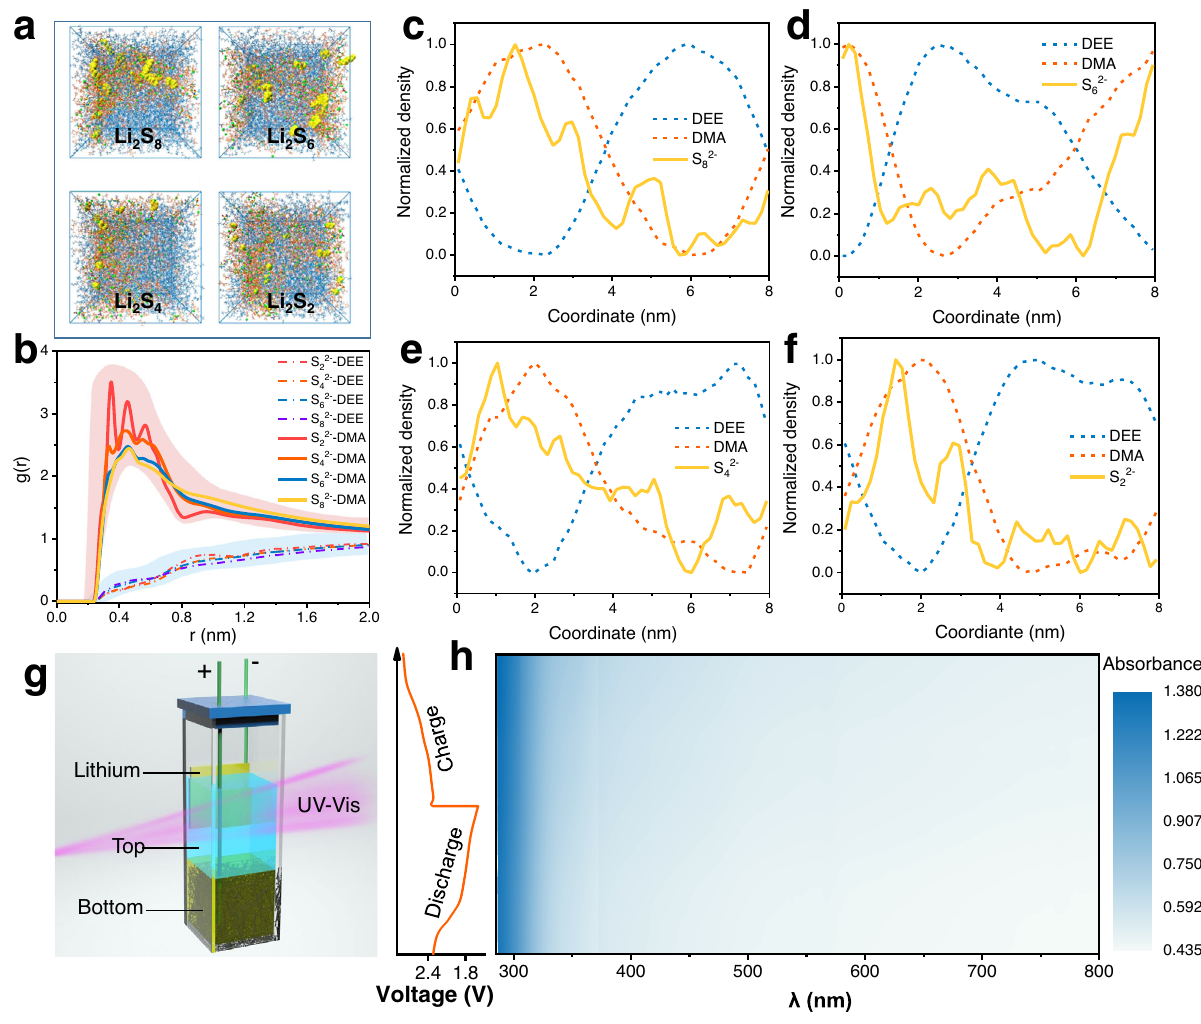
Fig. 4 | Polysul fi de-con fi nement effect of the DMA-DEE biphasic system. a Snapshots of the MD simulation of the No. 2 biphasic system contains different intermediates(Li 2 S 8 ,Li 2 S 6 ,Li 2 S 4 ,Li 2 S 2 ). b RDFsofpolysul fi deionsbetweenDEEand DMA. c , d , e , f Normalized spatial density distribution of DEE and DMA in No.2